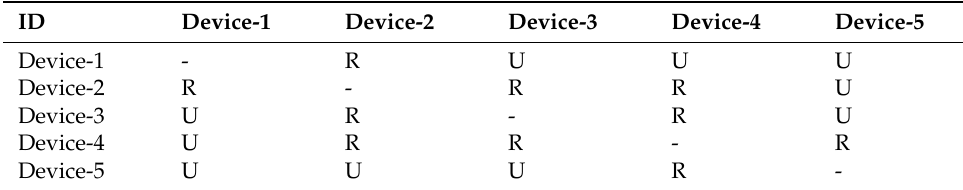
Table 4. Connectivity condition (R is reachable, U is